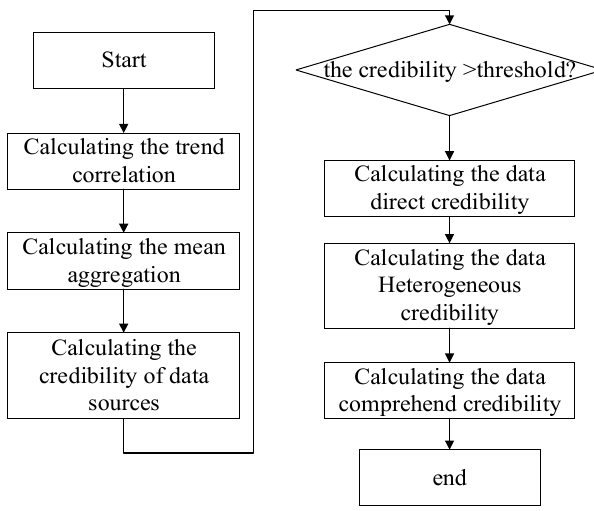
Figure 10. The flow chart of the experimental process. Next, the interfered target data and the data generated by its neighboring data sources are demonstrated in Figure 11.